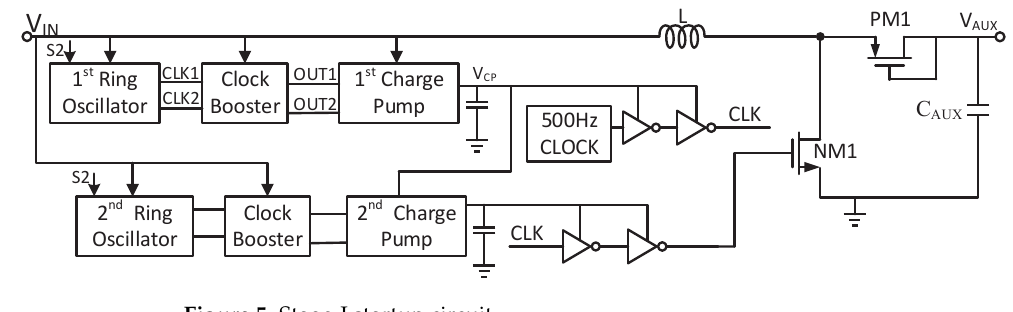
Figure 5. Stage-I startup circuit.